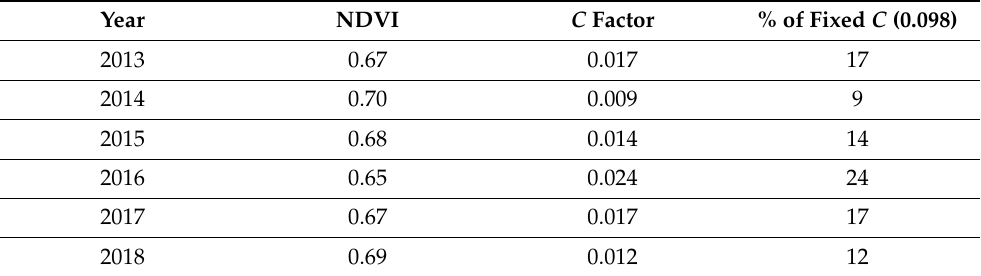
Table 3. Percentage variation between inter-annual (based on March values) and fixed C factors for catchment T35C.